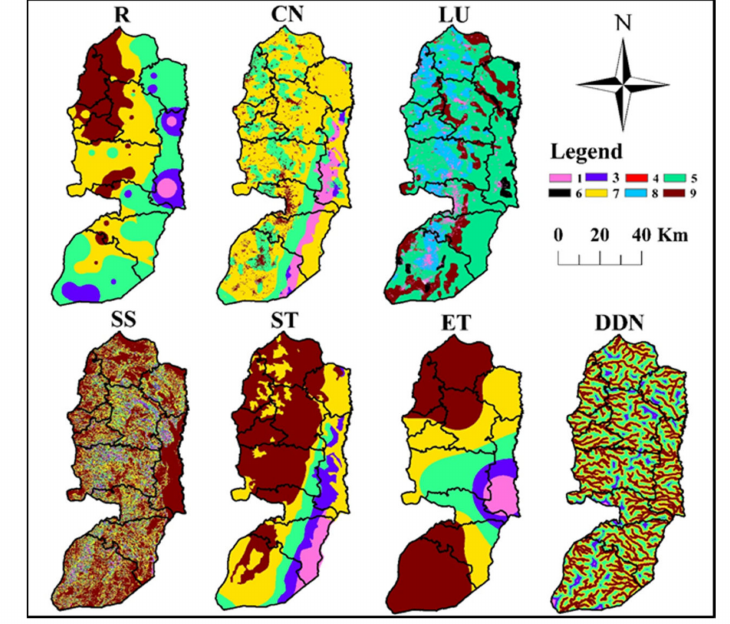
Figure 4. The score rasters of the seven ARWHS criteria for the West Bank case